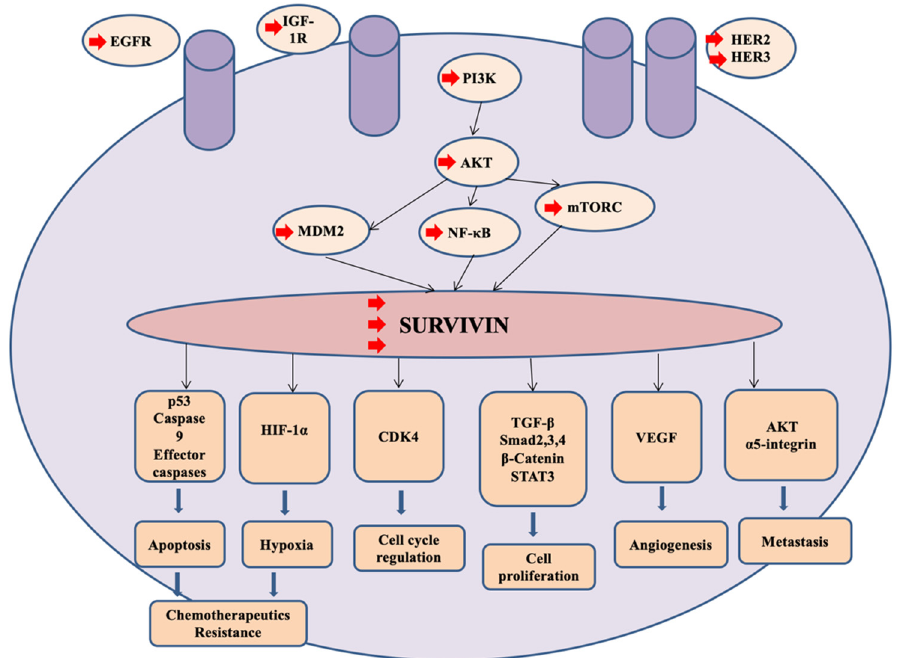
Figure 3. Survivin is a potential target for treatment patients with TNBC. Activation of several kinases such as HER2, HER3, IGF-1R and EGFR elicits PI3K / AKT signaling pathways resulting in upregulation of survivin expression. Overexpression of survivin stimulates numerous genes and proteins associated with cancerous cell proliferation and survival, migration, angiogenesis, and promotes chemoresistance.